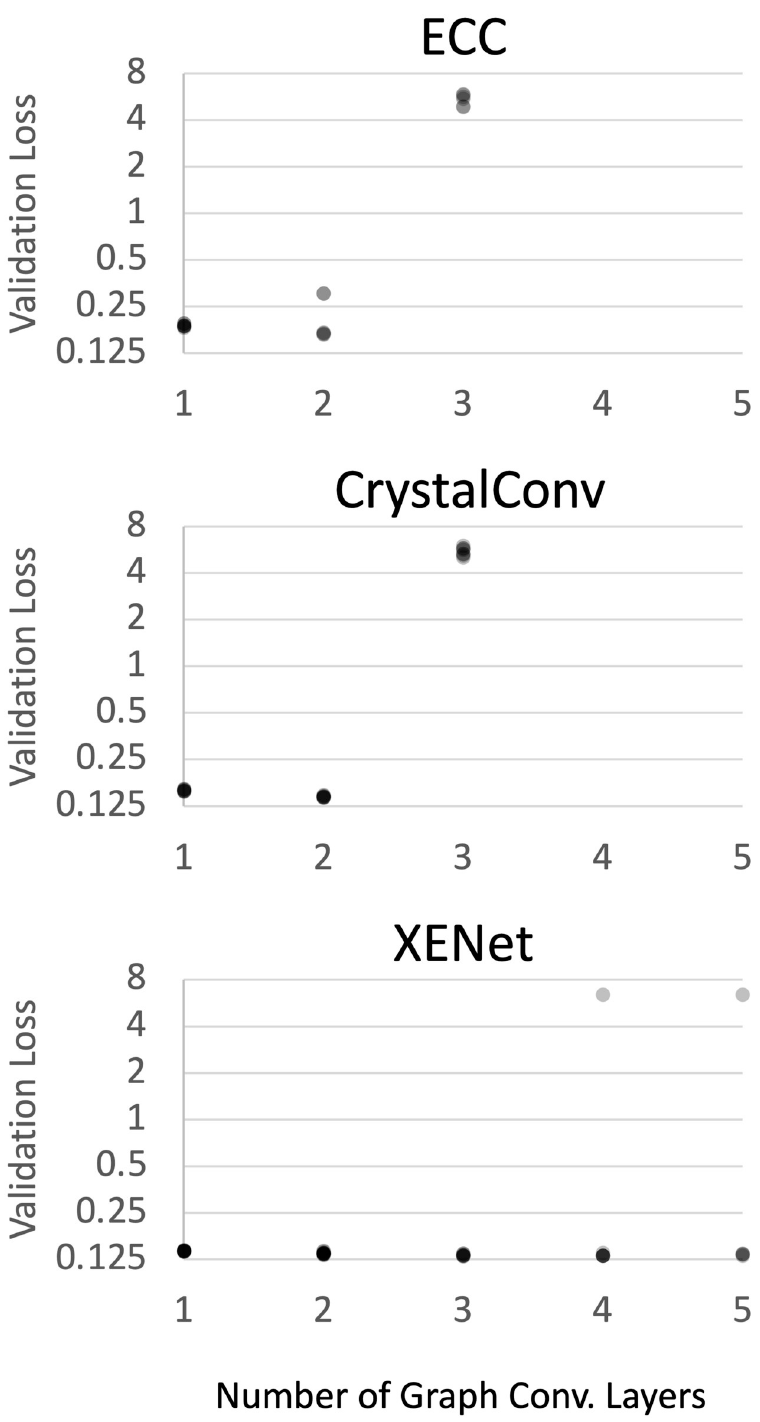
Fig 2. Depth comparison with fixed parameter count. We plot the losses of all trained ECC, CrystalConv (p), and XENet (p) models against the number of graph convolutional layers in each model. Transparency was applied to the points to help illustrate density. ECC and CrystalConv have no points with 4 or 5